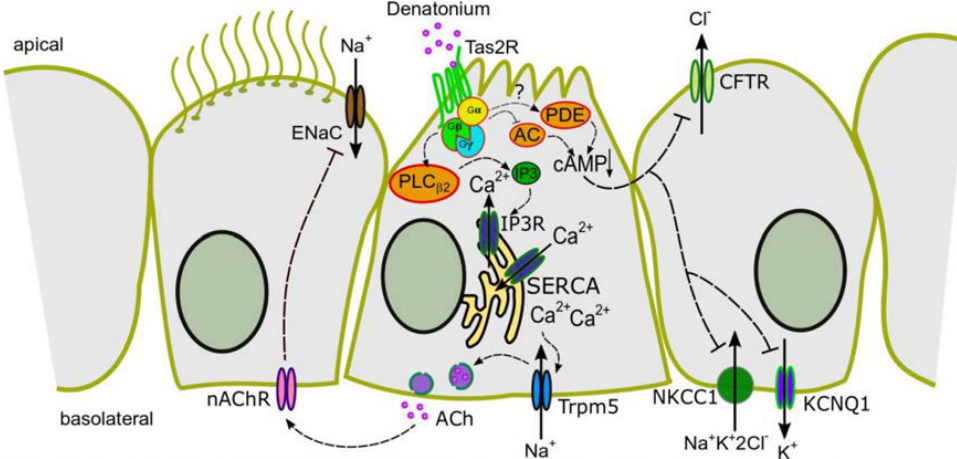
Figure 9. Proposed signalling pathway of the influence of denatonium on transepithelial ion transport. Denatonium binding to Tas2R in brush cells leads to a G βγ -dependent activation of PLC β 2 , which results in an activation of IP3 receptors. The increase in [Ca 2+ ] i leads to an activation of Trpm5 followed by a release of ACh. The released ACh then binds to nAChR on neighbouring cells, resulting in an inhibition of ENaC and chloride channels. Simultaneously, the G α -dependent reduction of [cAMP] i in brush cells might lead to an additional decrease in ENaC, CFTR, and KCNQ1 as well as NKCC1